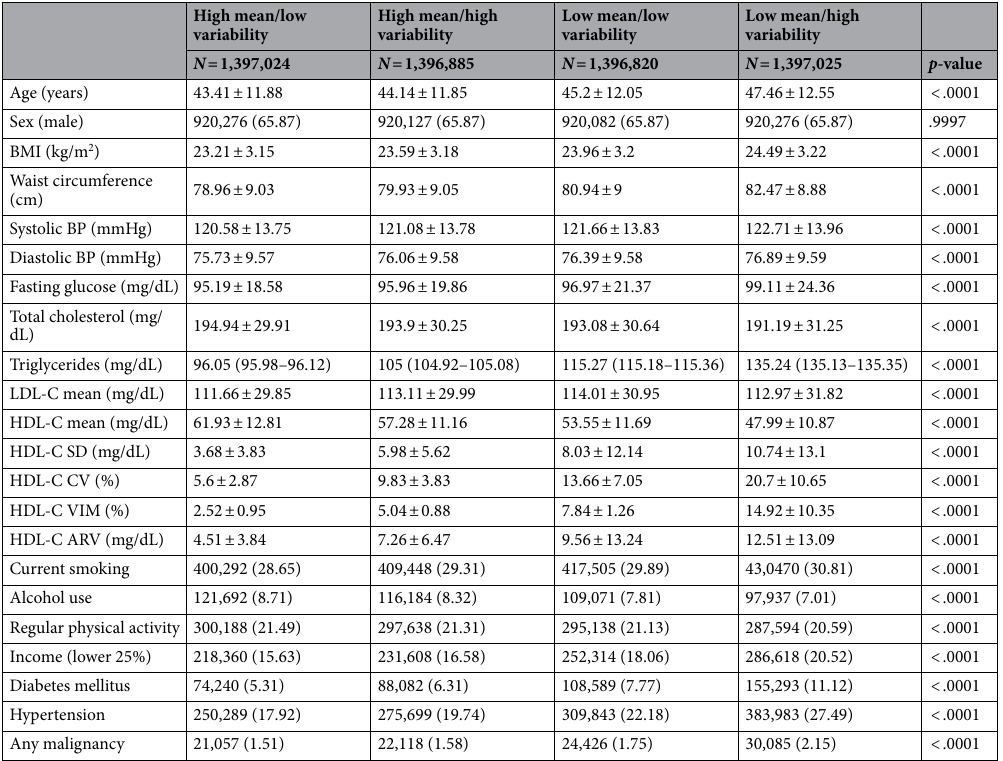
Table 1. Baseline characteristics of participants according to HDL-C levels (mean value and variability therein). Data are expressed as mean ± SD, median (25–75%), or n (%). The low mean group includes participants in the first quartile of mean HDL-C (men: < 44.7 mg/dL, women: < 51.7 mg/dL), the high mean group includes those in the second to fourth quartiles, the low variability group includes the first to third quartiles of HDL-C variability, and the high variability group includes the fourth quartile (men: ≥ 10.4%, women: ≥ 8.5%). ARV average real variability, BMI body mass index, BP blood pressure, CV coefficient of variation, HDL-C high-density lipoprotein cholesterol, LDL-C low-density lipoprotein cholesterol, SD standard deviation, VIM variability independent of the